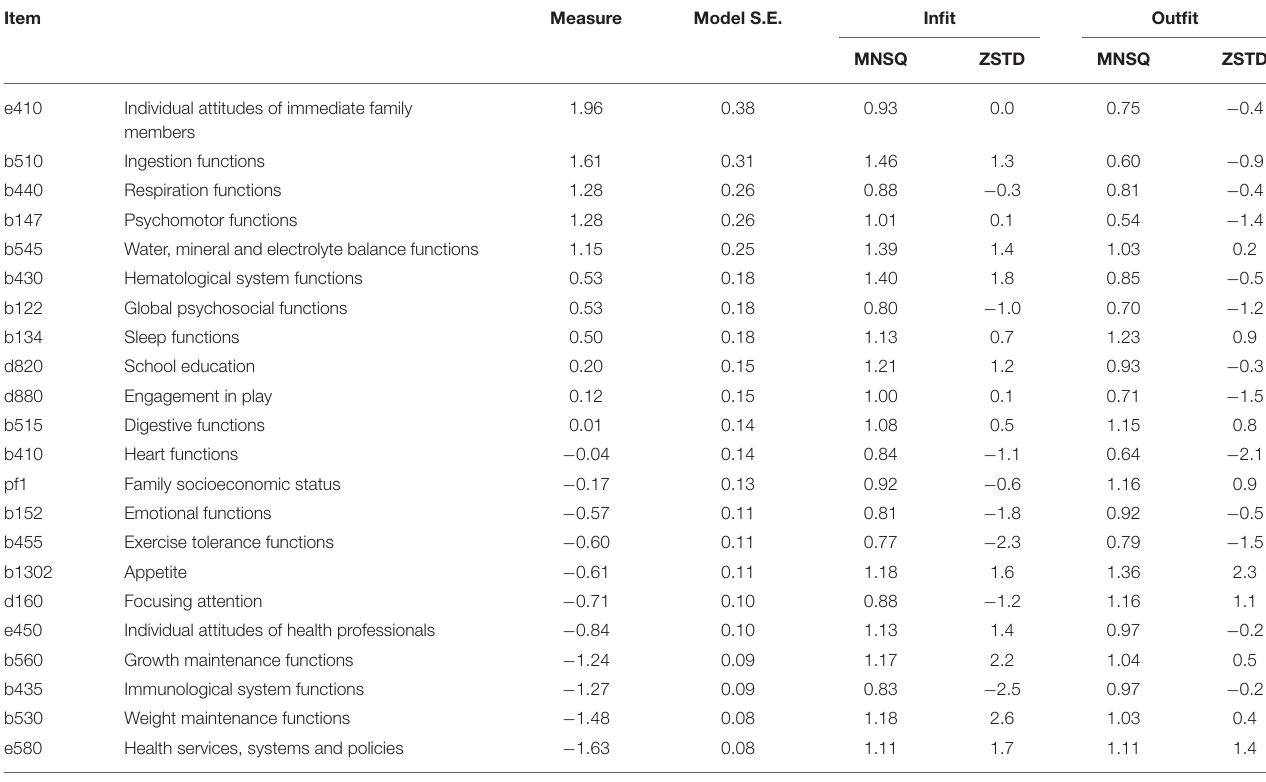
TABLE 4 | Categories retained after multiple rounds of Rasch analysis.